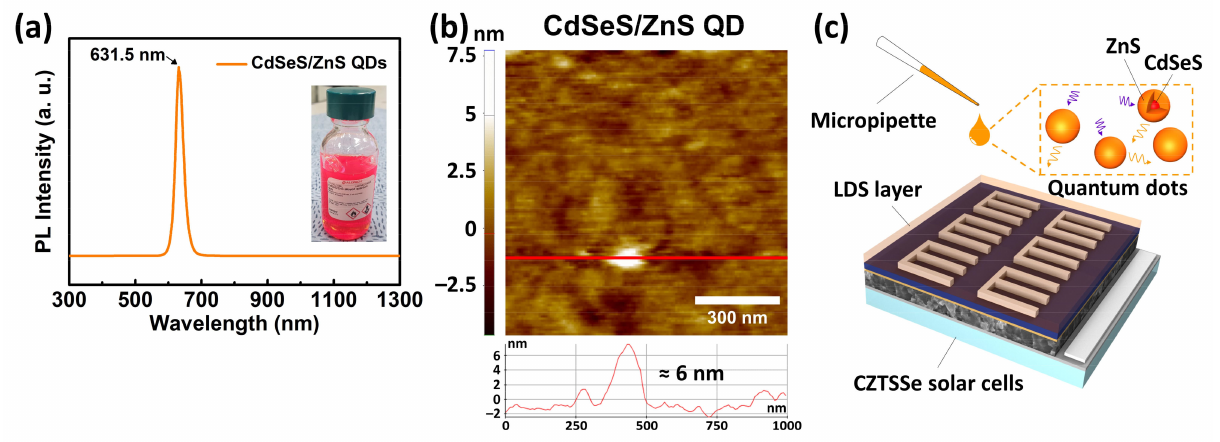
Figure 1. ( a ) Photoluminescence (PL) spectra, ( b ) atomic force microscopy (AFM) image of the core/shell CdSeS/ZnS quantum dots (QDs) on glass, and ( c ) schematic illustration of the luminescent down-shifting (LDS) layer on a CZTSSe solar cell prepared via